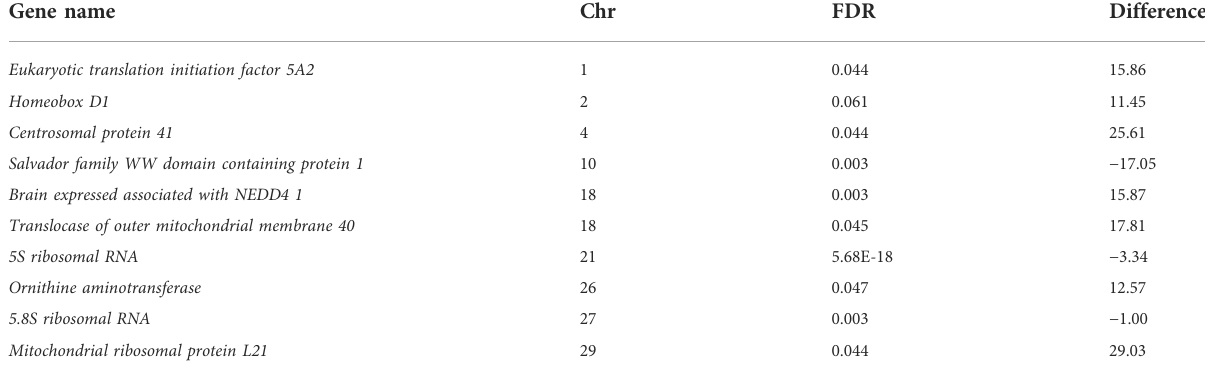
TABLE 1 Top 10 differentially methylated genes in amygdala tissue of prenatally stressed mature to Control cows.